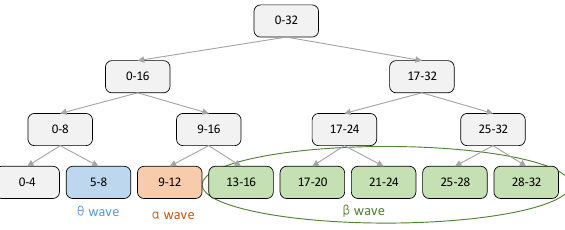
Figure 6. Schematic diagram of wavelet packet decomposition.